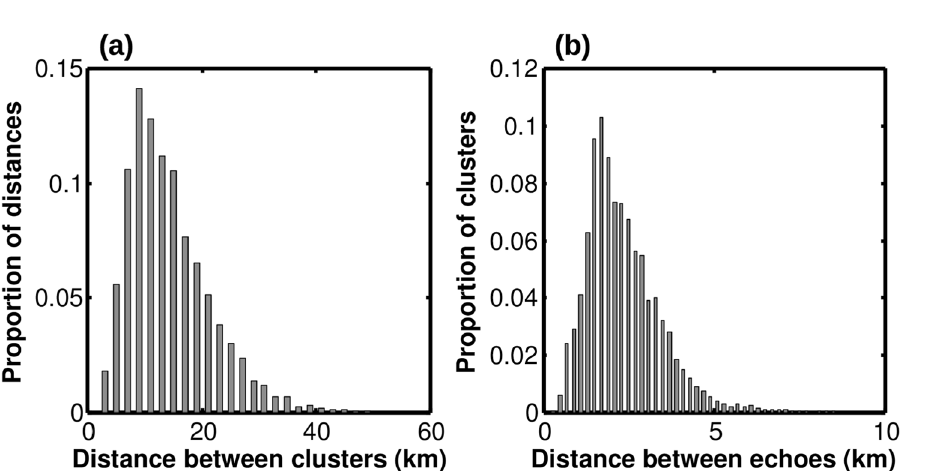
Figure 3. ( a ) Distribution of distances between synchronous clusters’ centroids (km). ( b ) Distribution of the mean distance between echoes within clusters